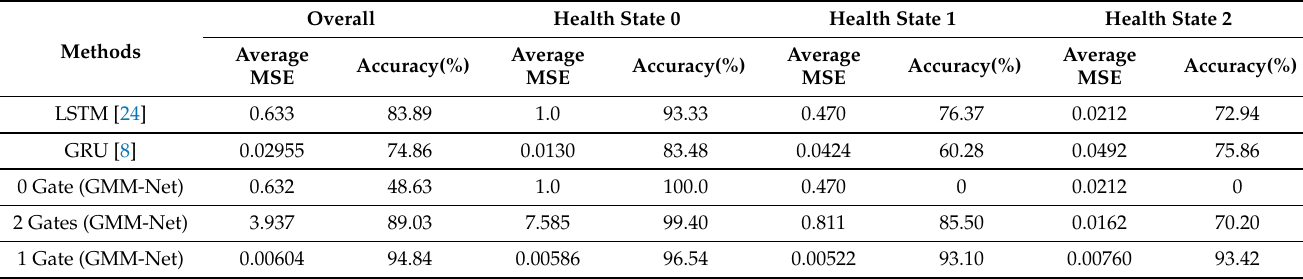
Table 1. Average MSE and accuracy of three health